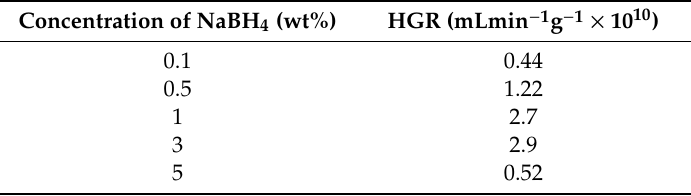
Table 2. List of HGR values of di ff erent NaBH 4